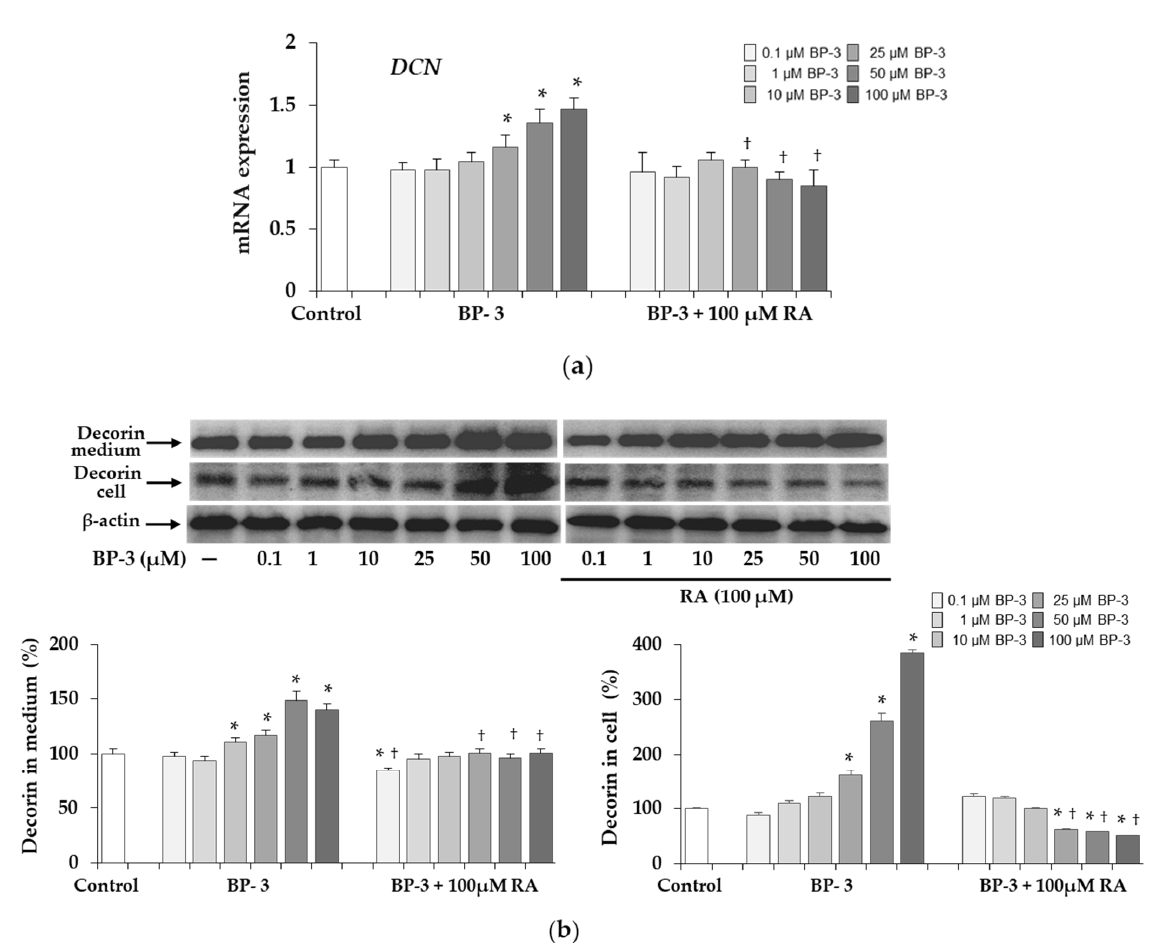
7 of 22 Figure 5. The expression of unspliced and spliced X-box binding protein 1 ( Xbp-1us and Xbp-1s ) in fibroblasts treated with benzophenone-3 (BP-3) alone and in combination with rosmarinic acid (RA). The PCR products were analyzed on 8% polyacrylamide